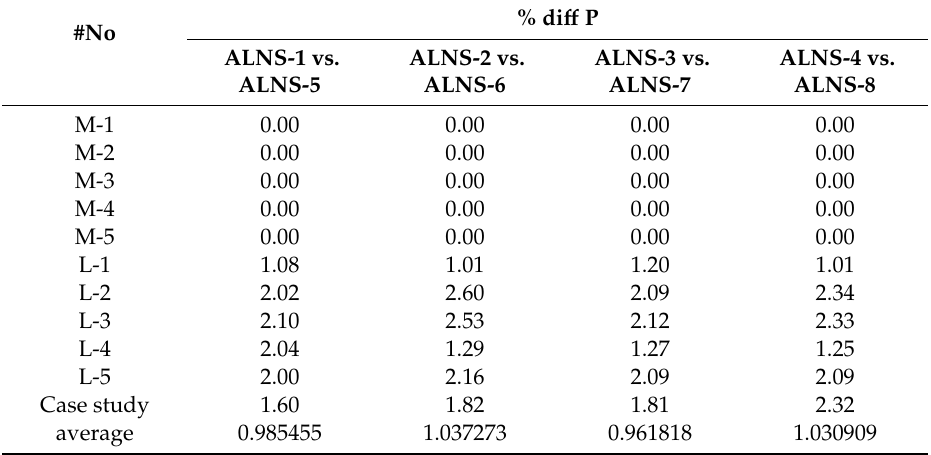
Table 12. Profit percentage di ff erence between the defender and challenger algorithms.